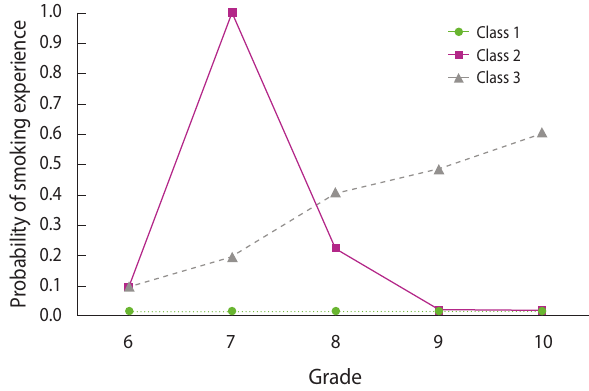
Figure 2. Probability of smoking experience among class 1, 2, and 3 in male adolescent. Class 1, non-users; Class 2, temporary users; Class 3, continuous